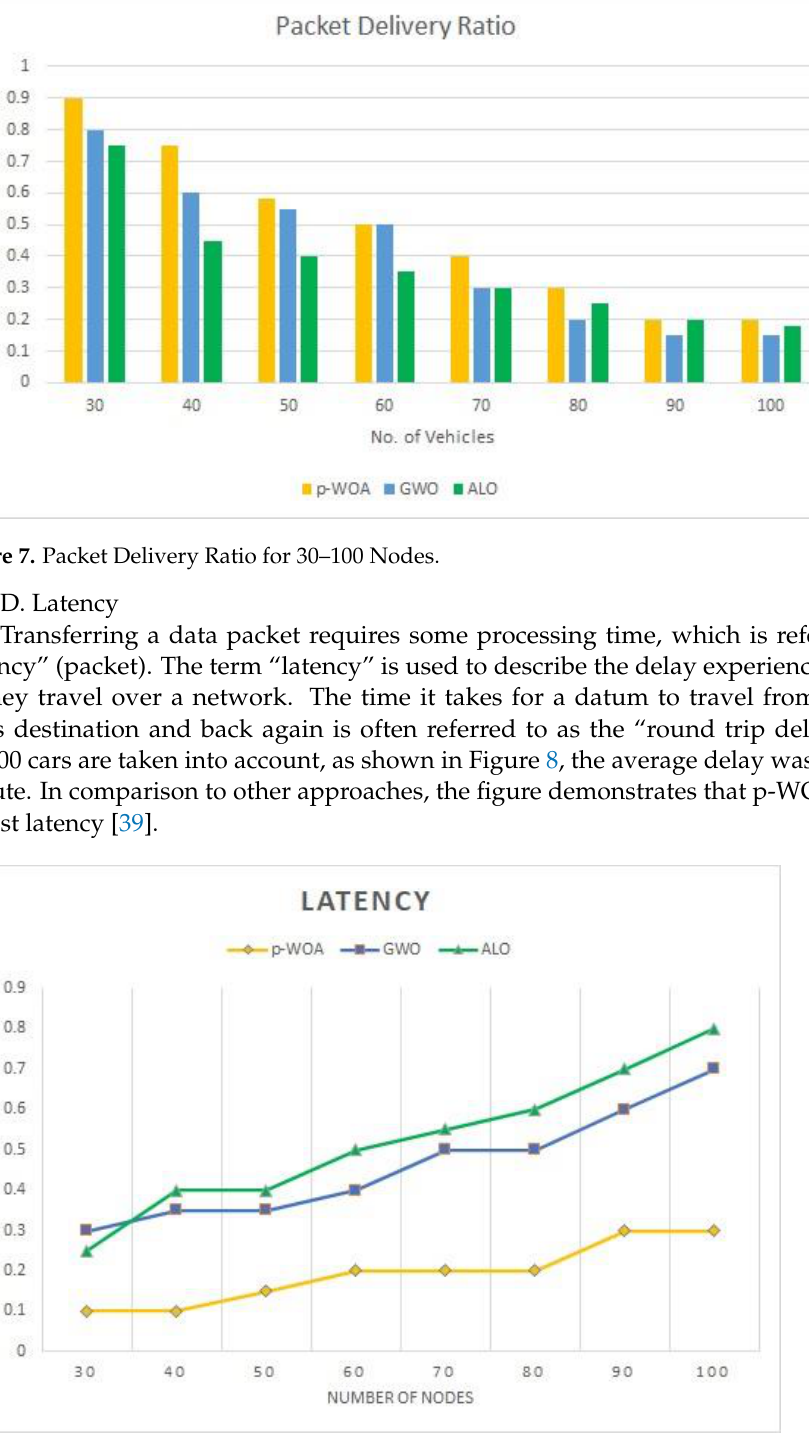
Figure 6. Comparison of 40 Nodes on a Grid with Different Numbers of Clusters .